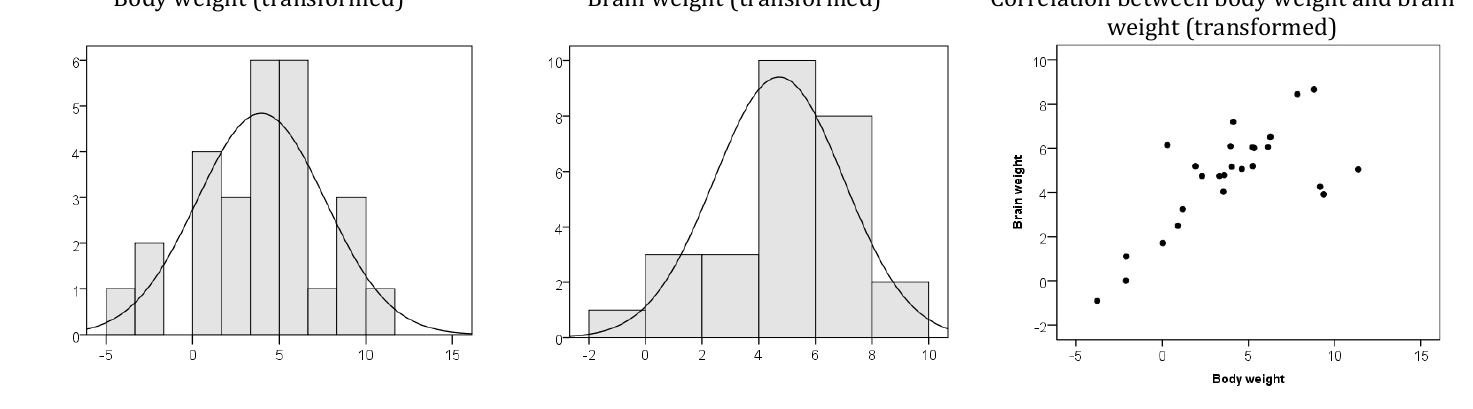
Body weight (transformed) Brain weight (transformed) Correlation between body weight and brain